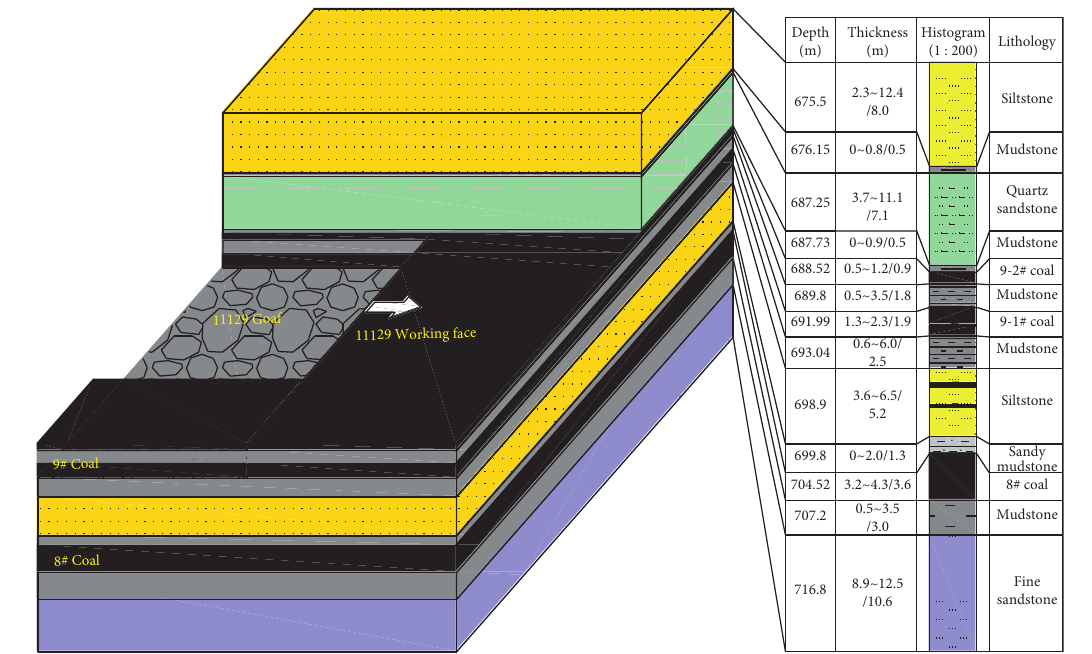
Figure 1: Comprehensive histogram of mining face in Zhangji Coal